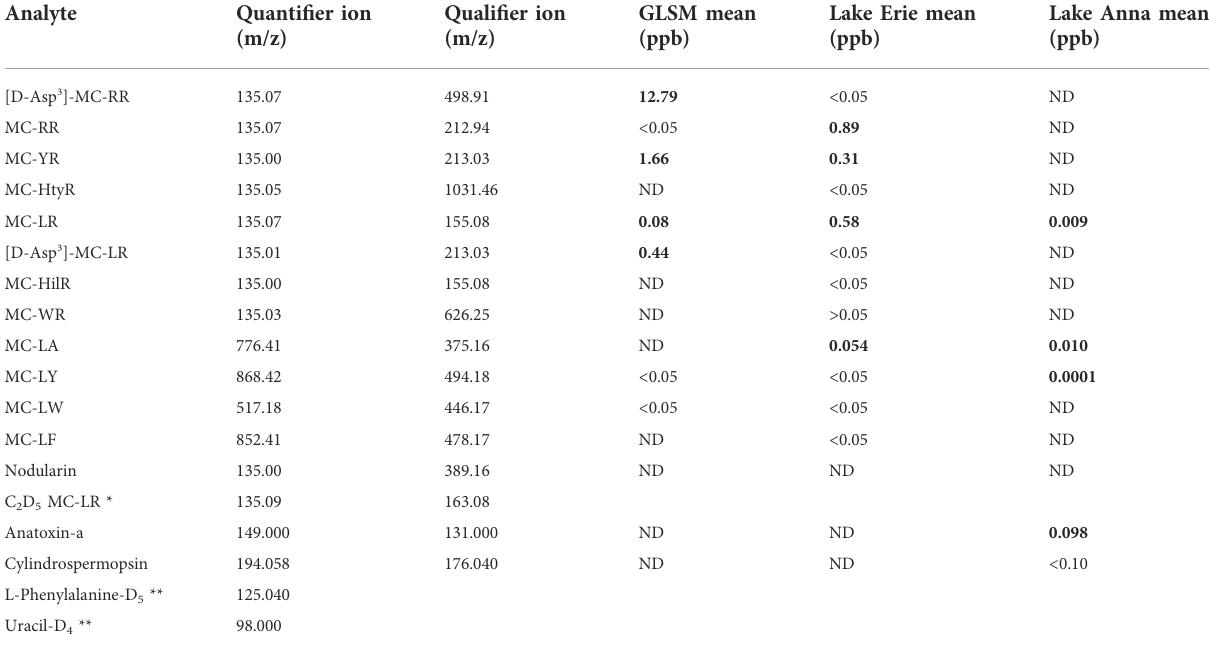
TABLE 3 List of 15 cyanotoxins analyzed in drone water samples. Toxins not detected are noted as ND. The MCs present at a mean above 0.05 ppb at GLSM and Lake Erie are noted in bold and shown in Figure 4 for two fl ights from each lake. At Lake Anna three MC were detected in addition to Anatoxin-a. These toxins are noted in bold and shown for two fl ights from Lake Anna (Figure 4).